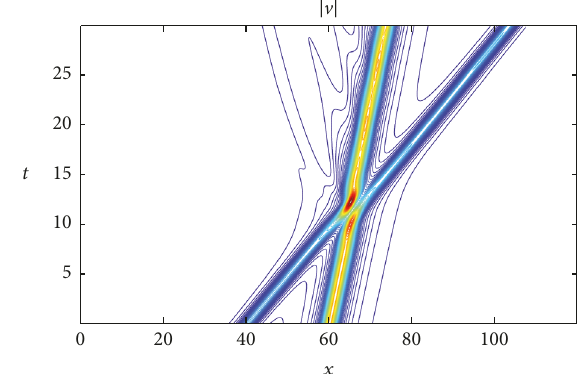
Figure 23: Wave-crest trajectory of collision of the two solitary waves of different speed and amplitude shown in Figure